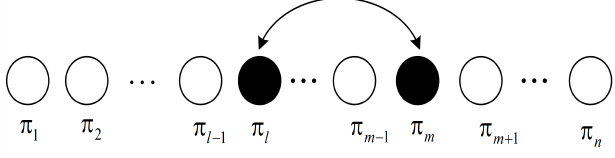
Figure 3. Illustration of Swap